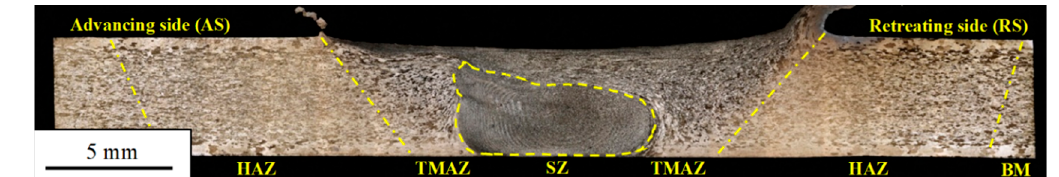
Figure 4. Macrostructure of the joint cross-section with distinguished zones.